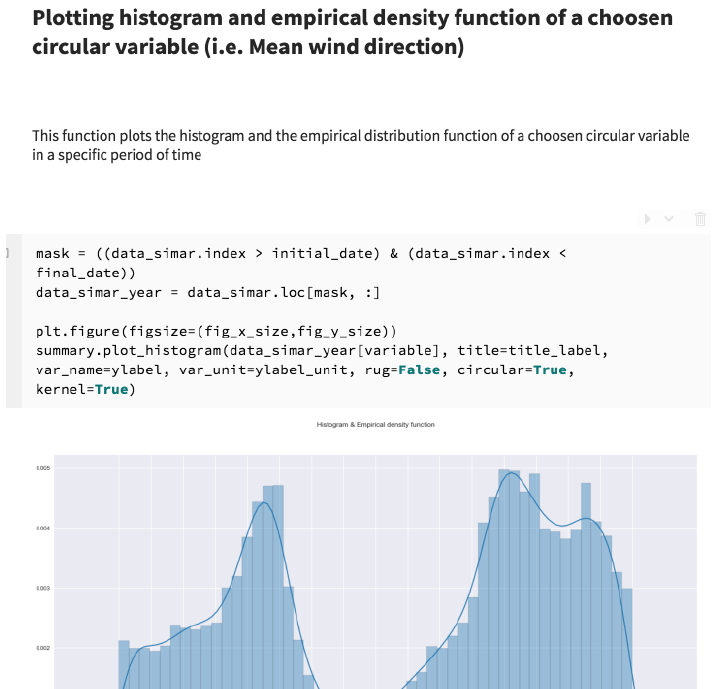
Figure 5. Histogram and empirical density function of a circular variable in the form of a Jupyter